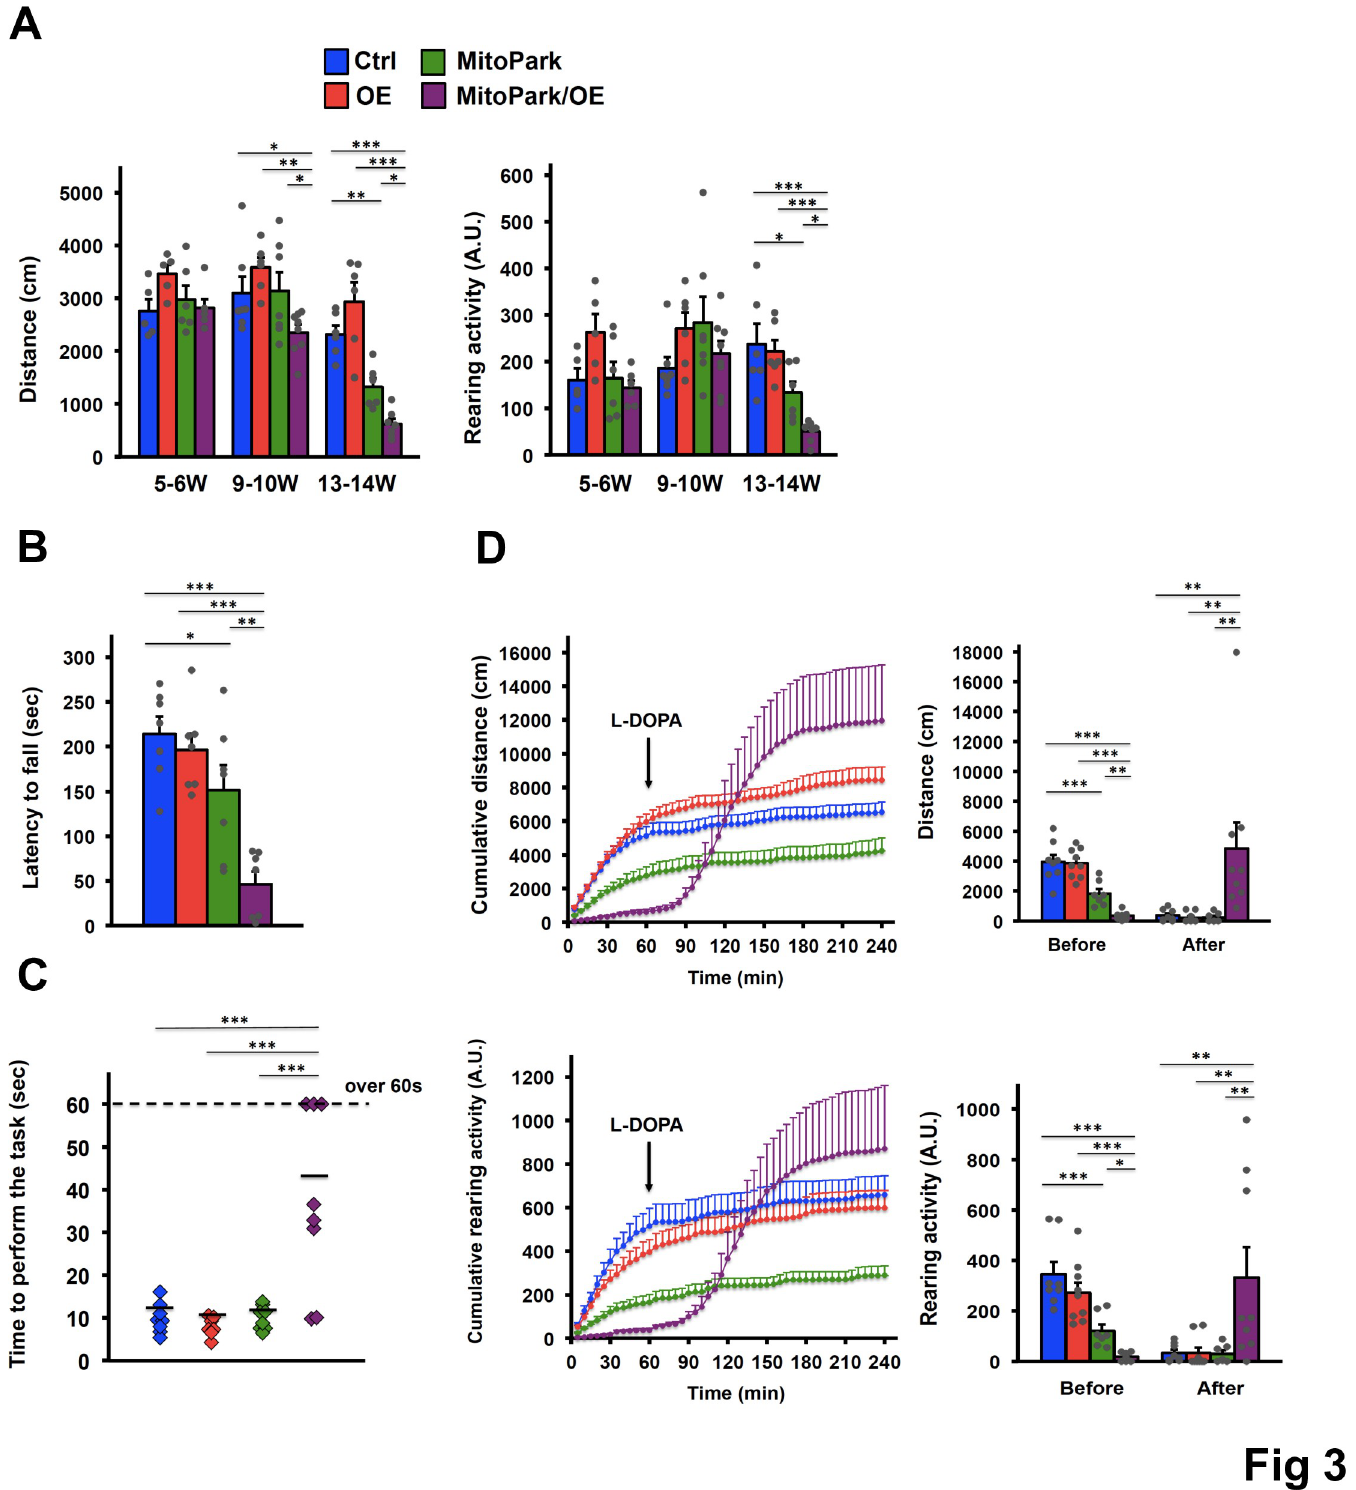
Fig 3. Accelerated motor symptoms of MitoPark mice by elevated COUP-TFII expression, which can be reversed by L-DOPA treatment. (A) Open-field assay recorded for Ctrl, OE, MitoPark, and MitoPark/OE mice at 5–6, 9–10, and 13–14 weeks of age. n = 5-8/group. (B) Rotarod performance test recorded for 15- to 18-week- old mice. n = 7/group. (C) Pole test recorded for 12- to 15-week-old mice. n = 7-8/group. (D) Open-field assay recorded for 15- to 16-week-old mice treated with